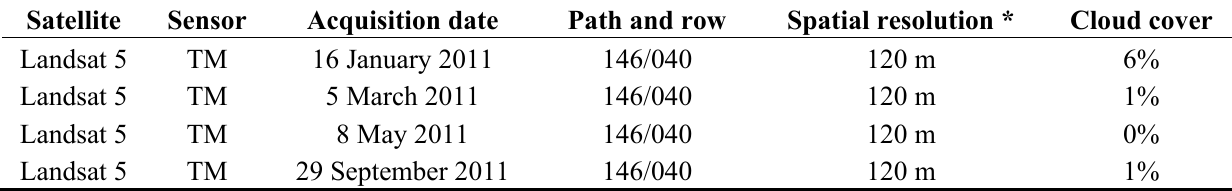
Table 1. Details of acquired and used satellite images